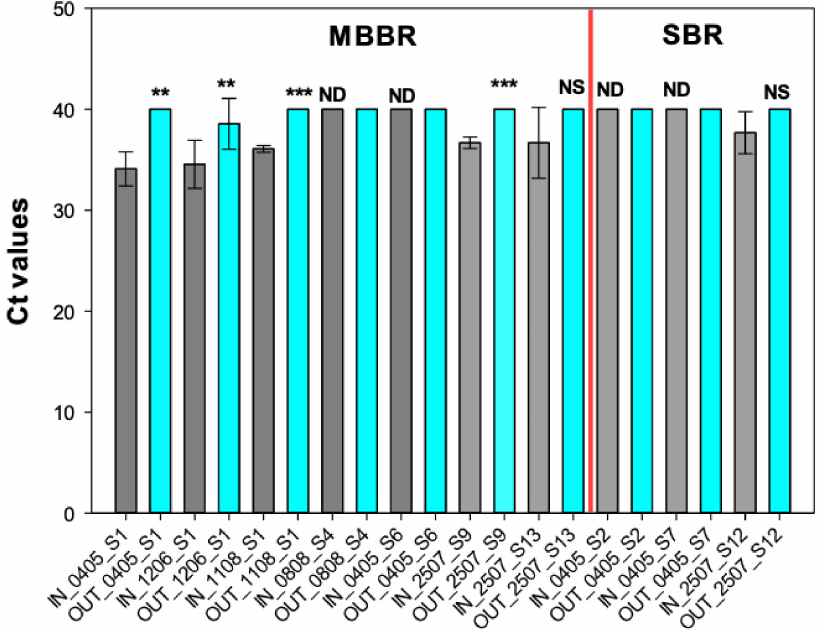
Figure 4. Paired T-test between the inlet and outlet wastewater samples, taken on the same date for SARS-CoV-2 genetic load in Moving bed Bioreactor (MBBR) based treatment and Sequencing batch reactors (SBR). where *** = p < 0.01; ** = p < 0.05; NS = not significant; ND = not detected; and RT-PCR was run for 40